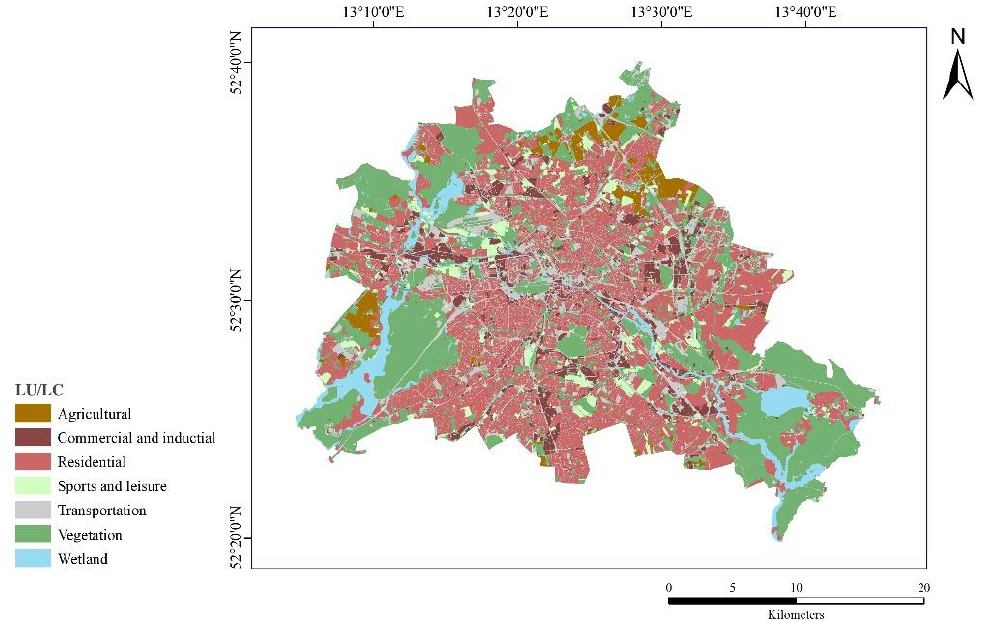
Figure 2. The classification of land use/land cover map in Berlin in 2018 based on the European Urban Atlas. Table 2. Classification of urban land use